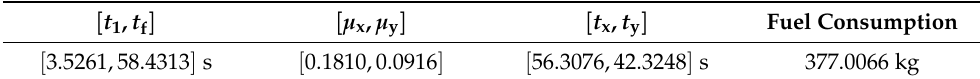
Table 3. Vacuum solution of Example